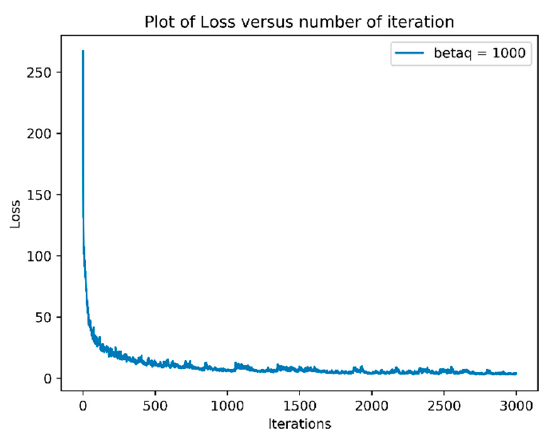
Figure 6. The relationship of the total loss of the exponential-based model at different iteration loops during the training process. Table 2. Fine-tuning error of the exponential-based model with various orientation scaling coefficients, 𝛃 𝐪 .